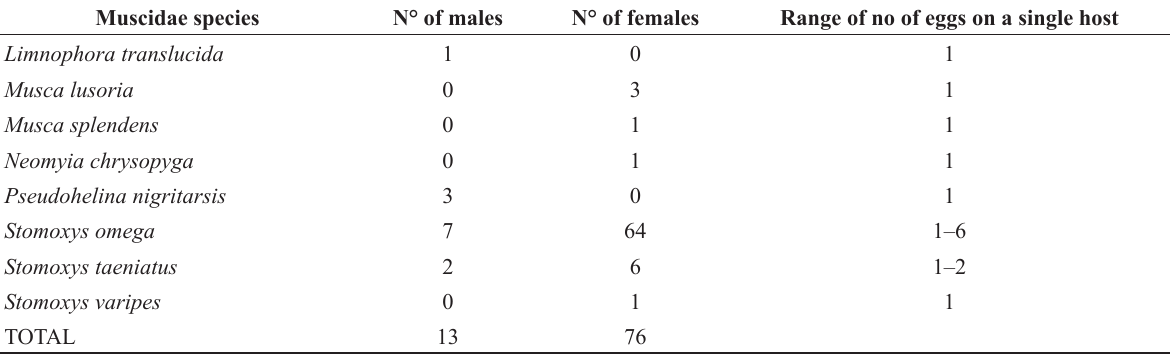
Muscidae species as Stylogaster (Conopidae) hosts in Ethiopia.